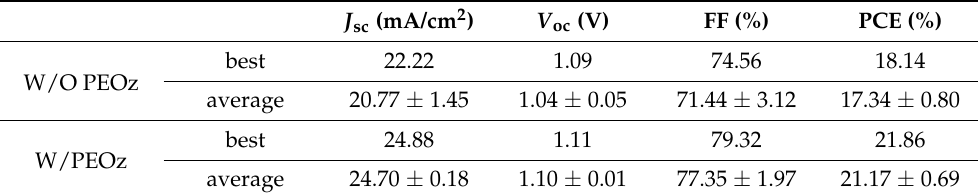
Figure 5. ( a ) Champion performance J-V characteristics of the control device and with PEOz − based device. ( b ) Steady output characteristics of the PEOz − based device. ( c ) IPCE curves and integrated current density and of ( d ) statistic result of PCE for the control devices and PEOz − based devices. Table 1. Photovoltaic parameters of the control devices and PEOz-based